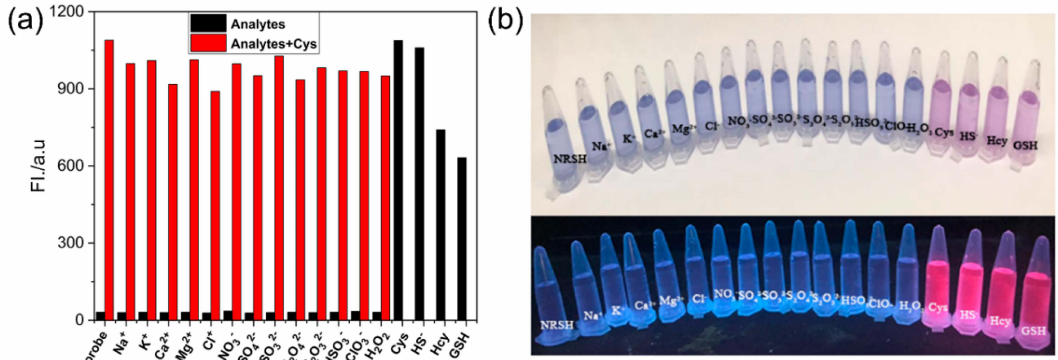
Figure 3. ( a ) Fluorescence responses of NRSH (10 µ M) in the presence of di ff erent analytes (black bars), followed by addition of Cys (30 µ M) (red bars); ( b ) Photographs observed after the addition of various analytes to the solution of NRSH under nature light (up) and 365 nm UV light (down). Conditions: incubating in the room temperature for 10 min, slit: excite = emission = 5 nm, λ ex = 567